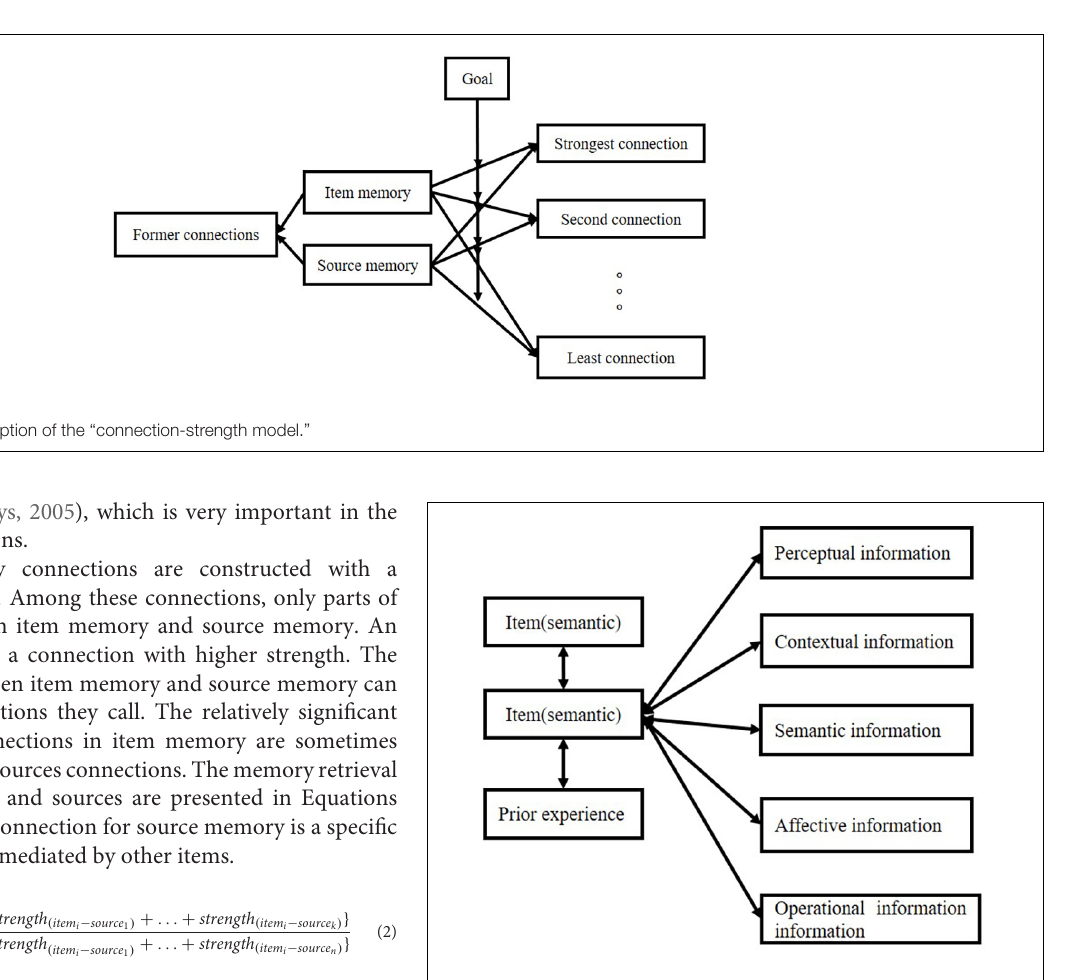
FIGURE 4 | Connection-strength model in item